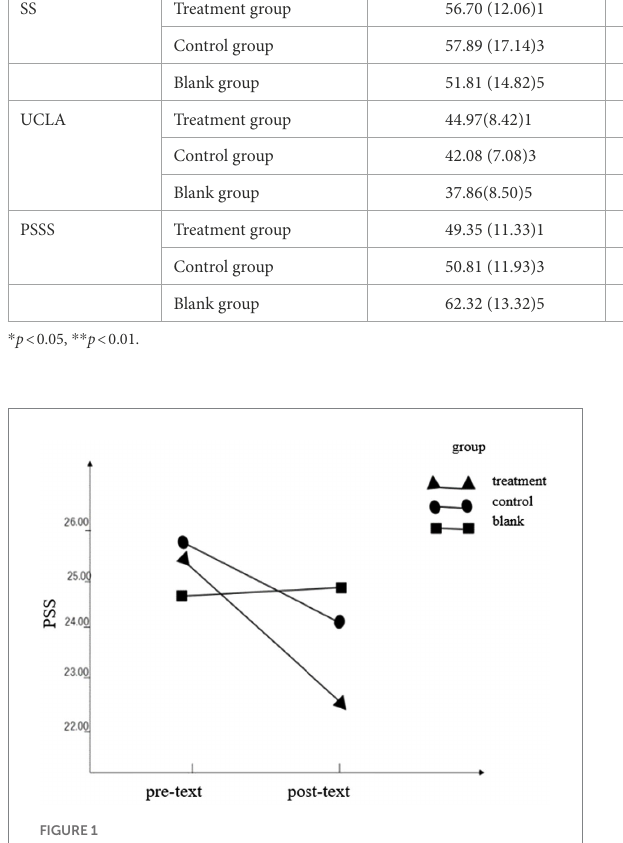
FIGURE 2 Pre- and post-text outcome of SS.